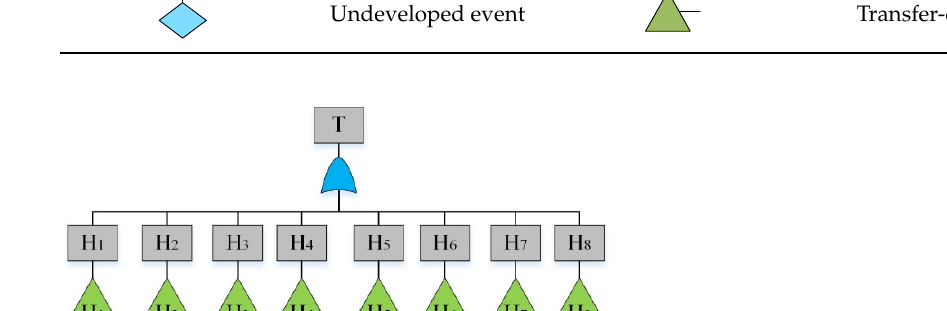
Figure 2. Fault tree of a hydraulic system: main tree.